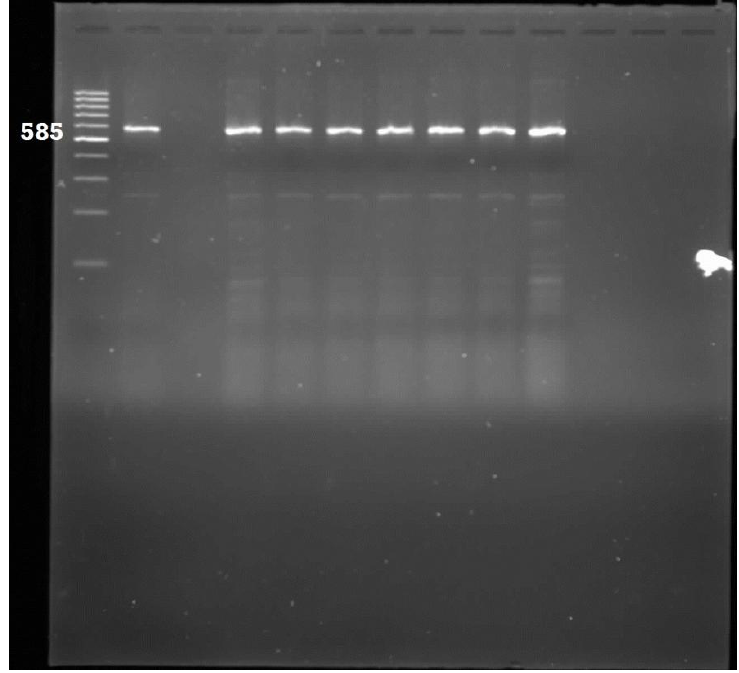
Figure 6. Gel electrophoresis for the detection of Uropathogenic E. coli amplicons. Lane 1: 100 bp ladder; Lane 2: Positive control; Lane 3: Negative control; Lane 4–10: Positive